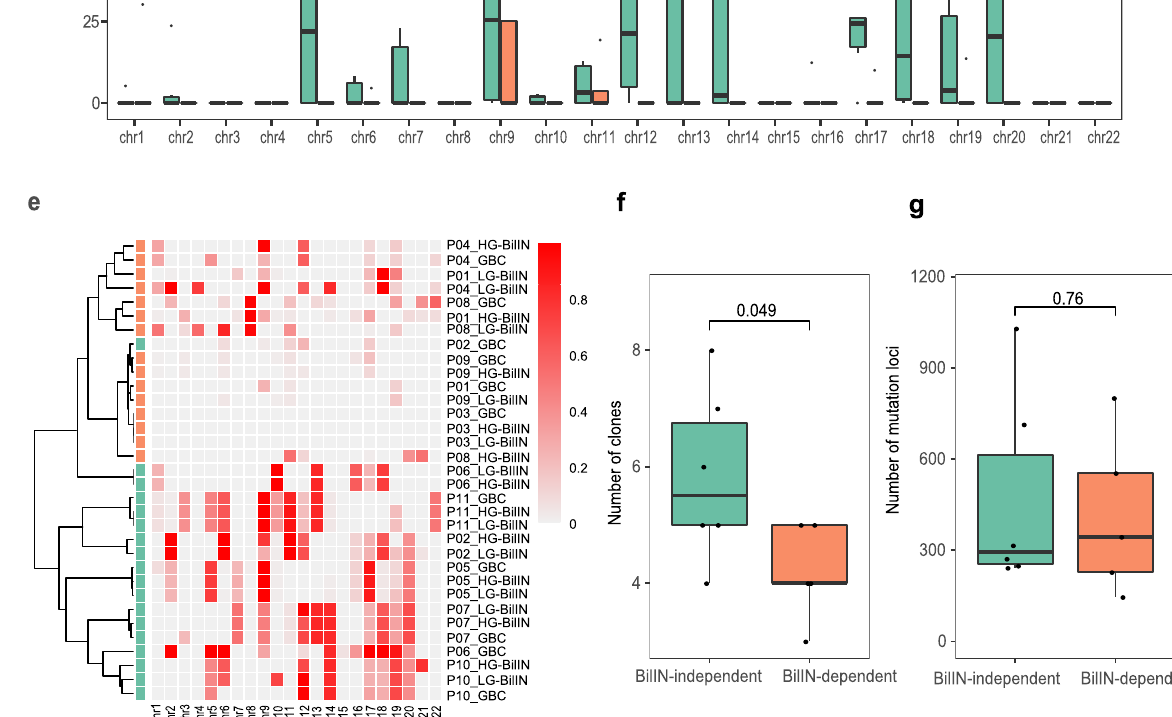
HG-BilIN/GBC samples at the chromosome level, we found that chr5, chr17, chr18, and chr20 showed the most striking differences ( t -test, p < 0.05, Fig. 4d). Indeed, the clustering pattern of gallbladder tumors based on their chromosome-level LOH status largely recaptured the tumor group classi fi cation based on mutation-based tree topologies (Fig. 4e). To gain more insights NATURE COMMUNICATIONS| (2021) 12:4753